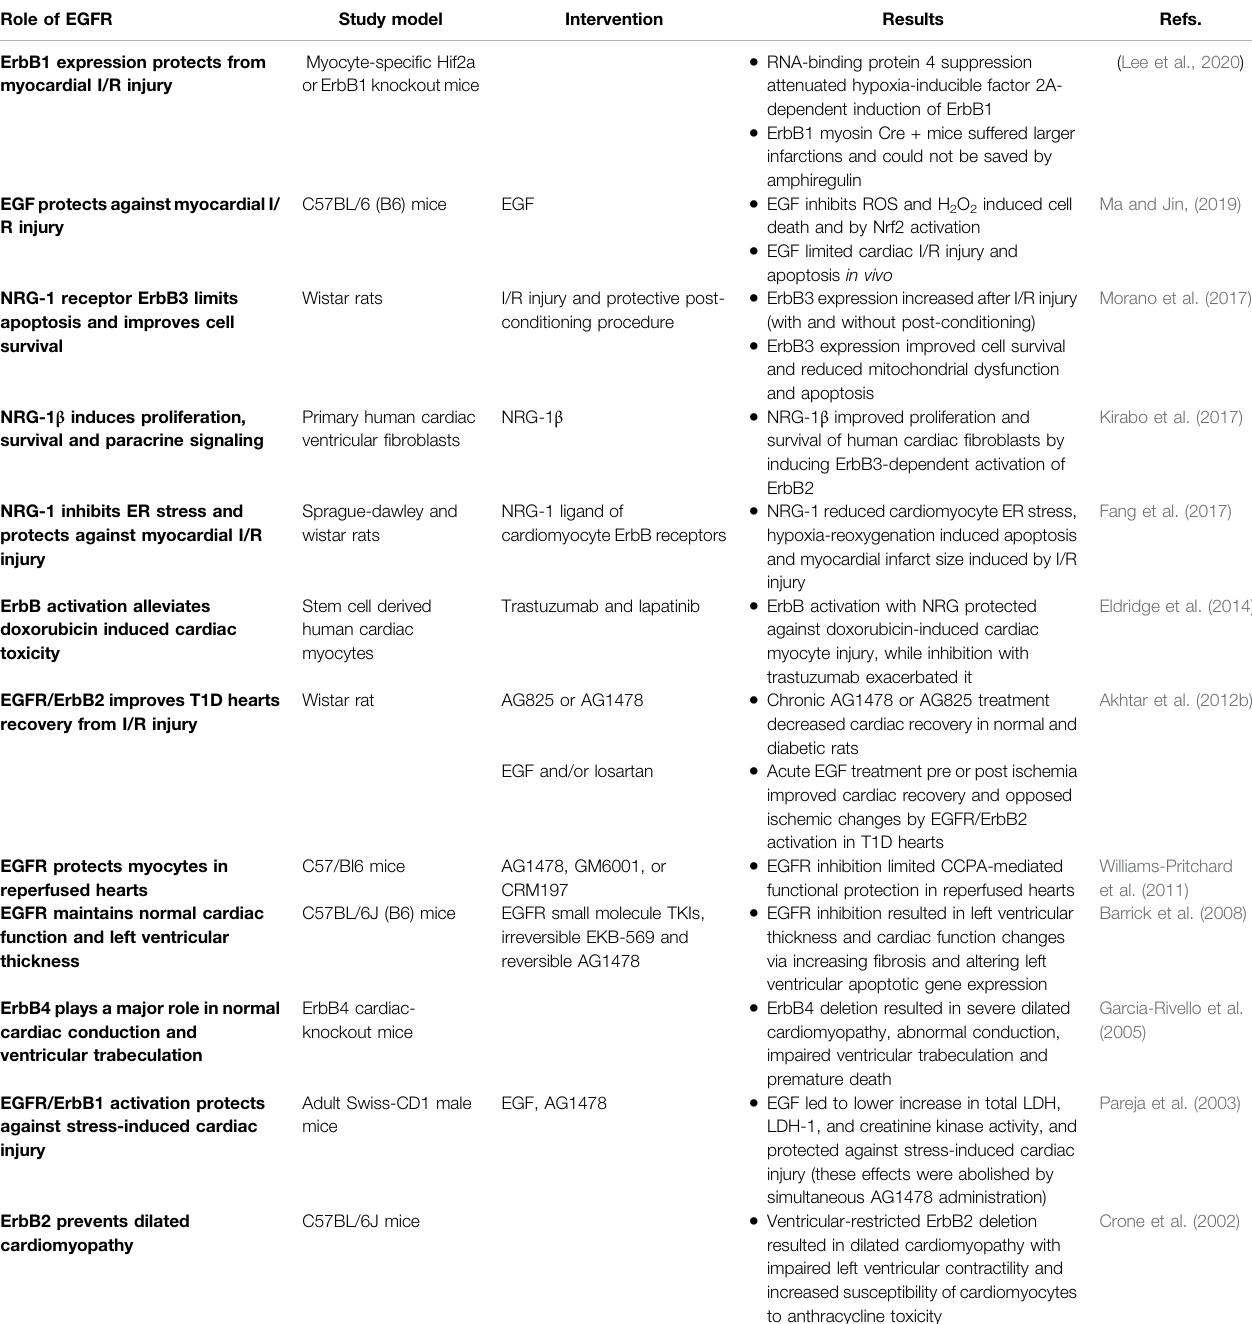
TABLE 1 | A summary of selected studies highlighting the bene fi cial role of EGFR signaling in the